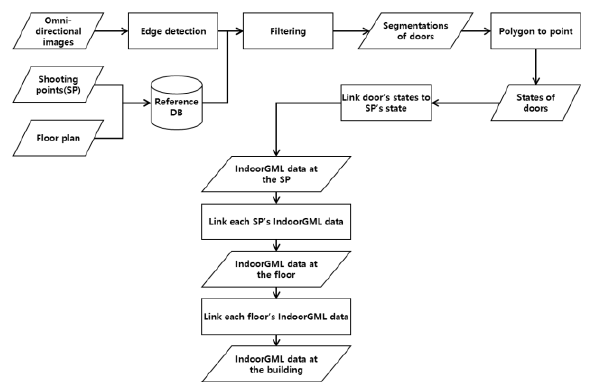
Figure 1. Flow chart of method